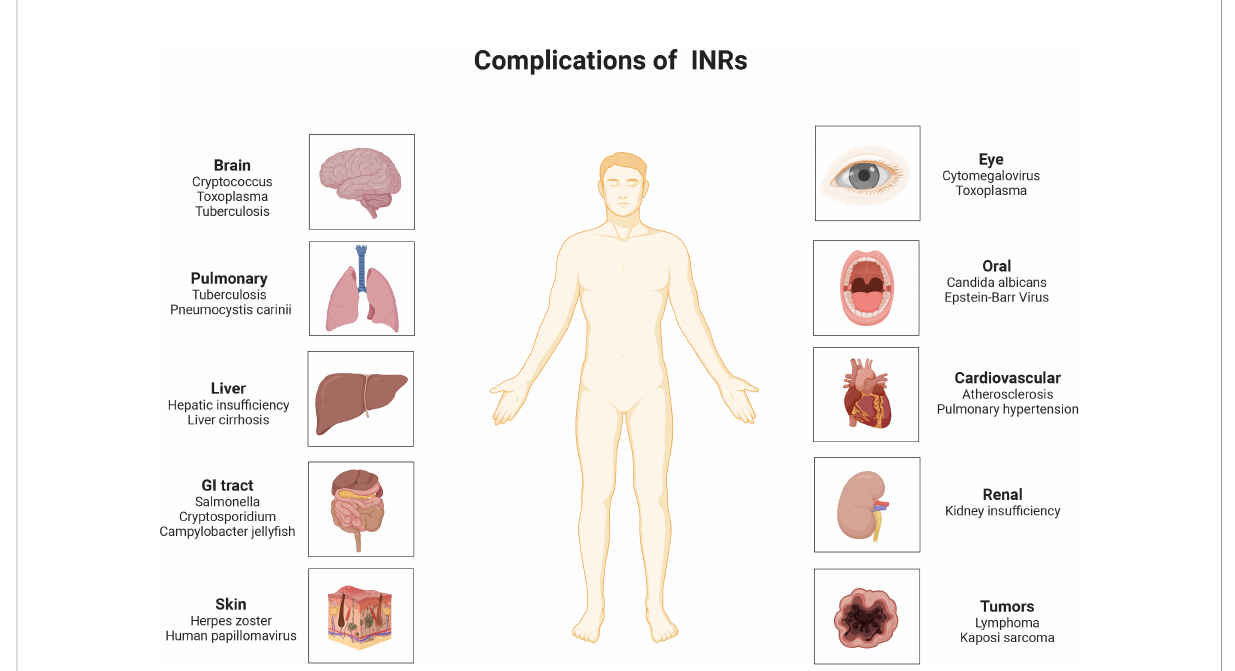
FIGURE 1 Opportunistic infections and diseases that are likely to complicate in INRs. INRs, immune